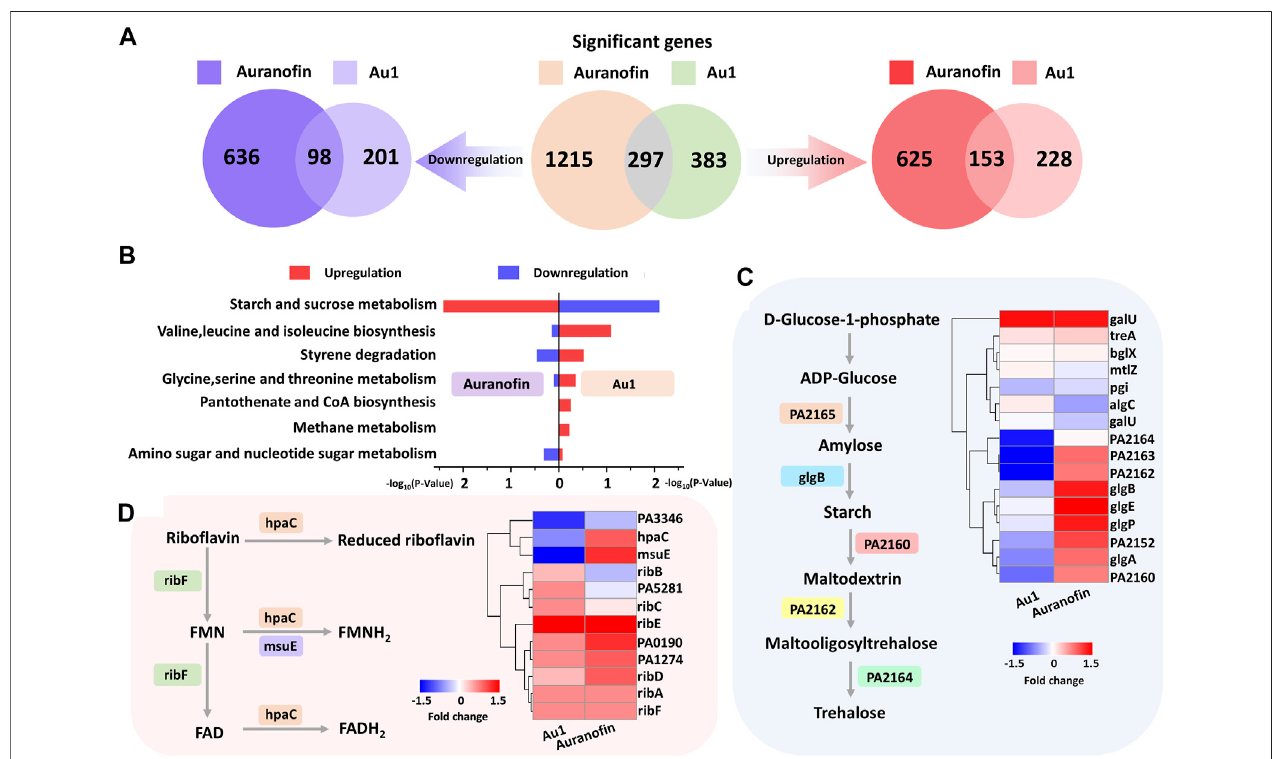
FIGURE4|(A) Venndiagramsshowingthenumberofup-and down-regulated genesintheAu1and auarno fi ntreatedgroupscompared tothecontrolgroup. (B) KEGG analysis reveal enrichment pathways that completely opposites under the treatment of Au1 and Aurano fi n (left panel represents aurano fi n-treated group, right panelrepresentsAu1-treatedgroup). (C) Starchandsucrosemetabolismpathway andtheheatmap forrelative genesof P.aeruginosa intheAu1and aurano fi ntreated groups. (D) Ribo fl avin biosynthesis pathway and the heat map for relative genes of P. aeruginosa in the Au1 and aurano fi n treated